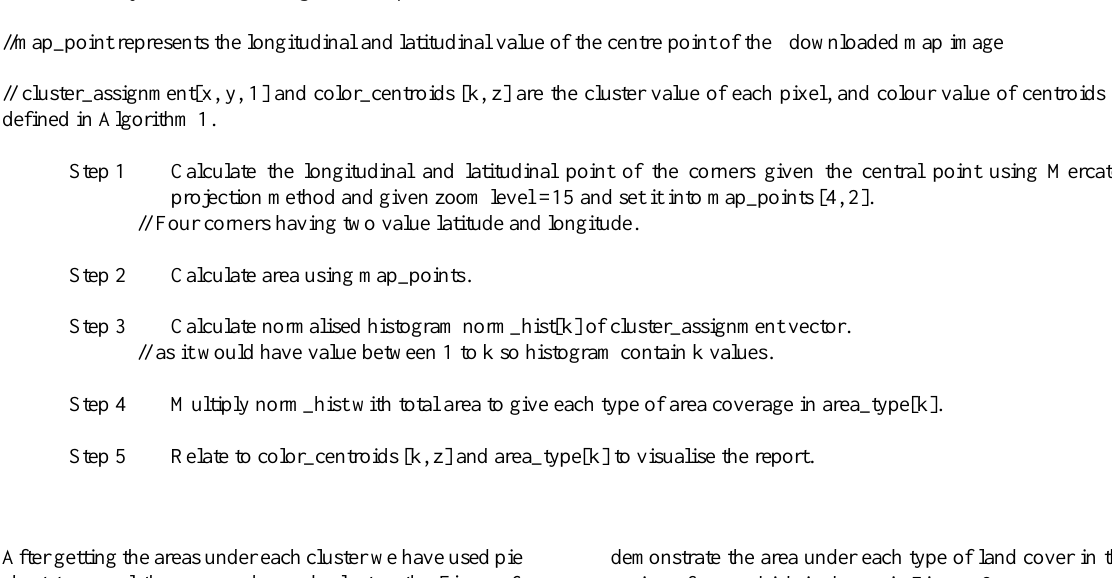
Algorithm 4: Calculate Area and Report (image[x, y, z], map_point [2], cluster_assignment[x, y, 1], color_centroids [k, z])